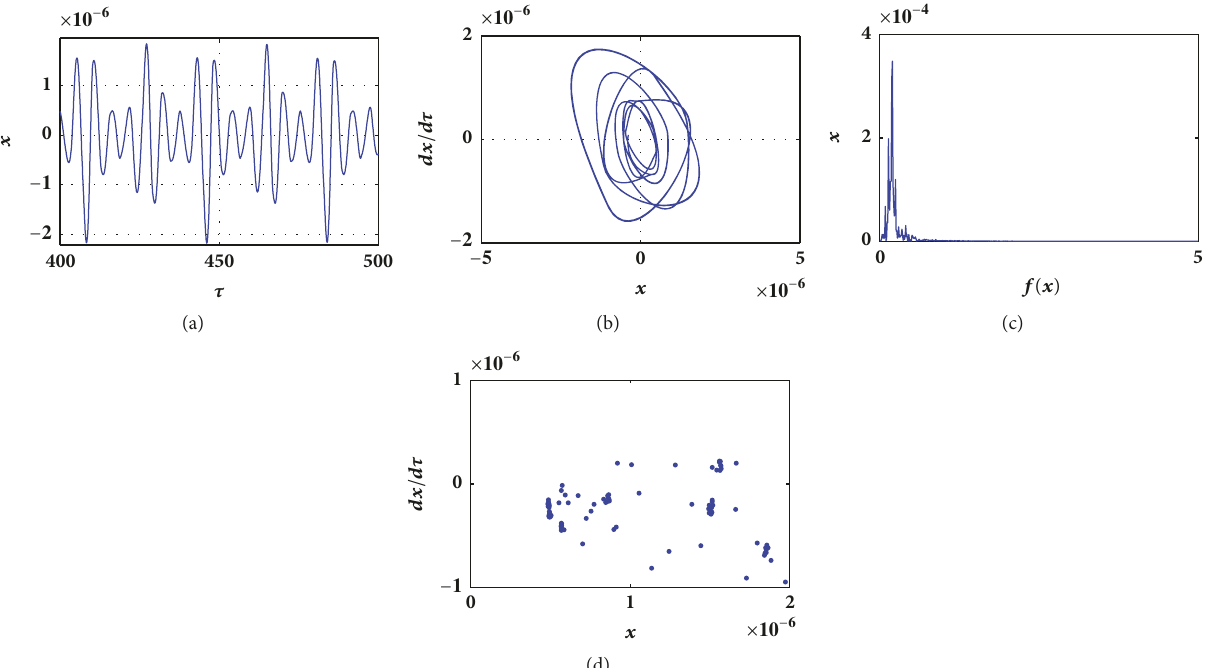
Figure 4: The time history, the phase diagram, spectrum, and the Poincar´e section of the system (6) for 𝜀 = 0.55 , 𝑄 = 1 .